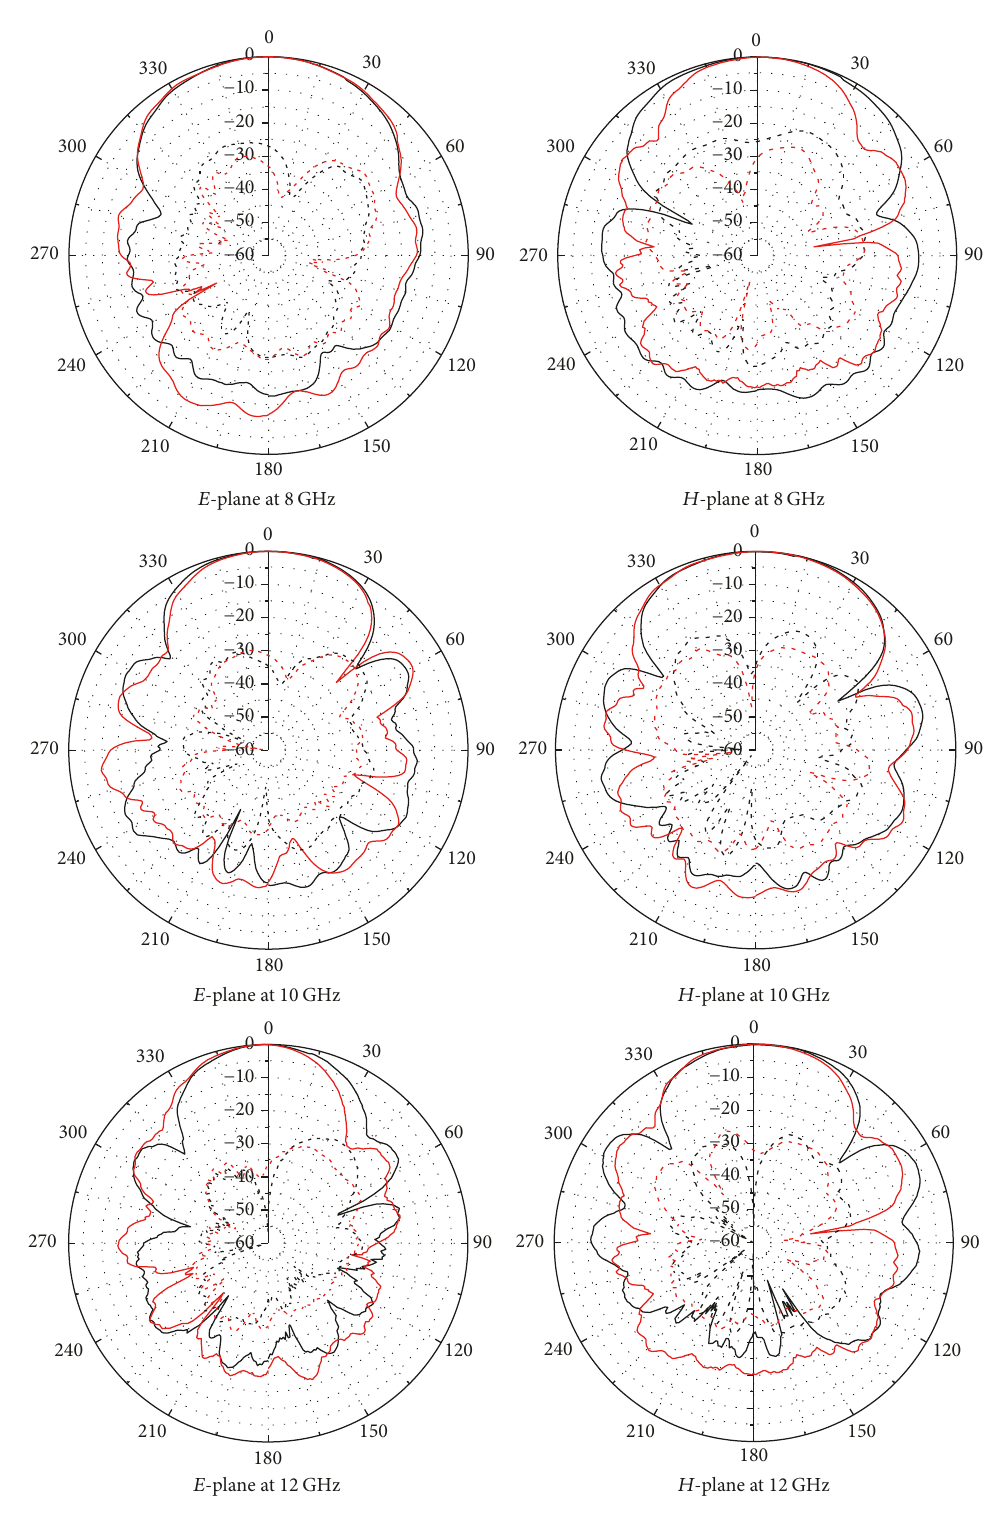
Figure 10: 𝐸 - and 𝐻 -plane radiation patterns of the antennas at different frequencies with black solid lines for Vivaldi 1 copolarization, red solid line for Vivaldi 2 copolarization, black short dash line for Vivaldi 1 cross-polarization, and red short dash line for Vivaldi 2 cross-